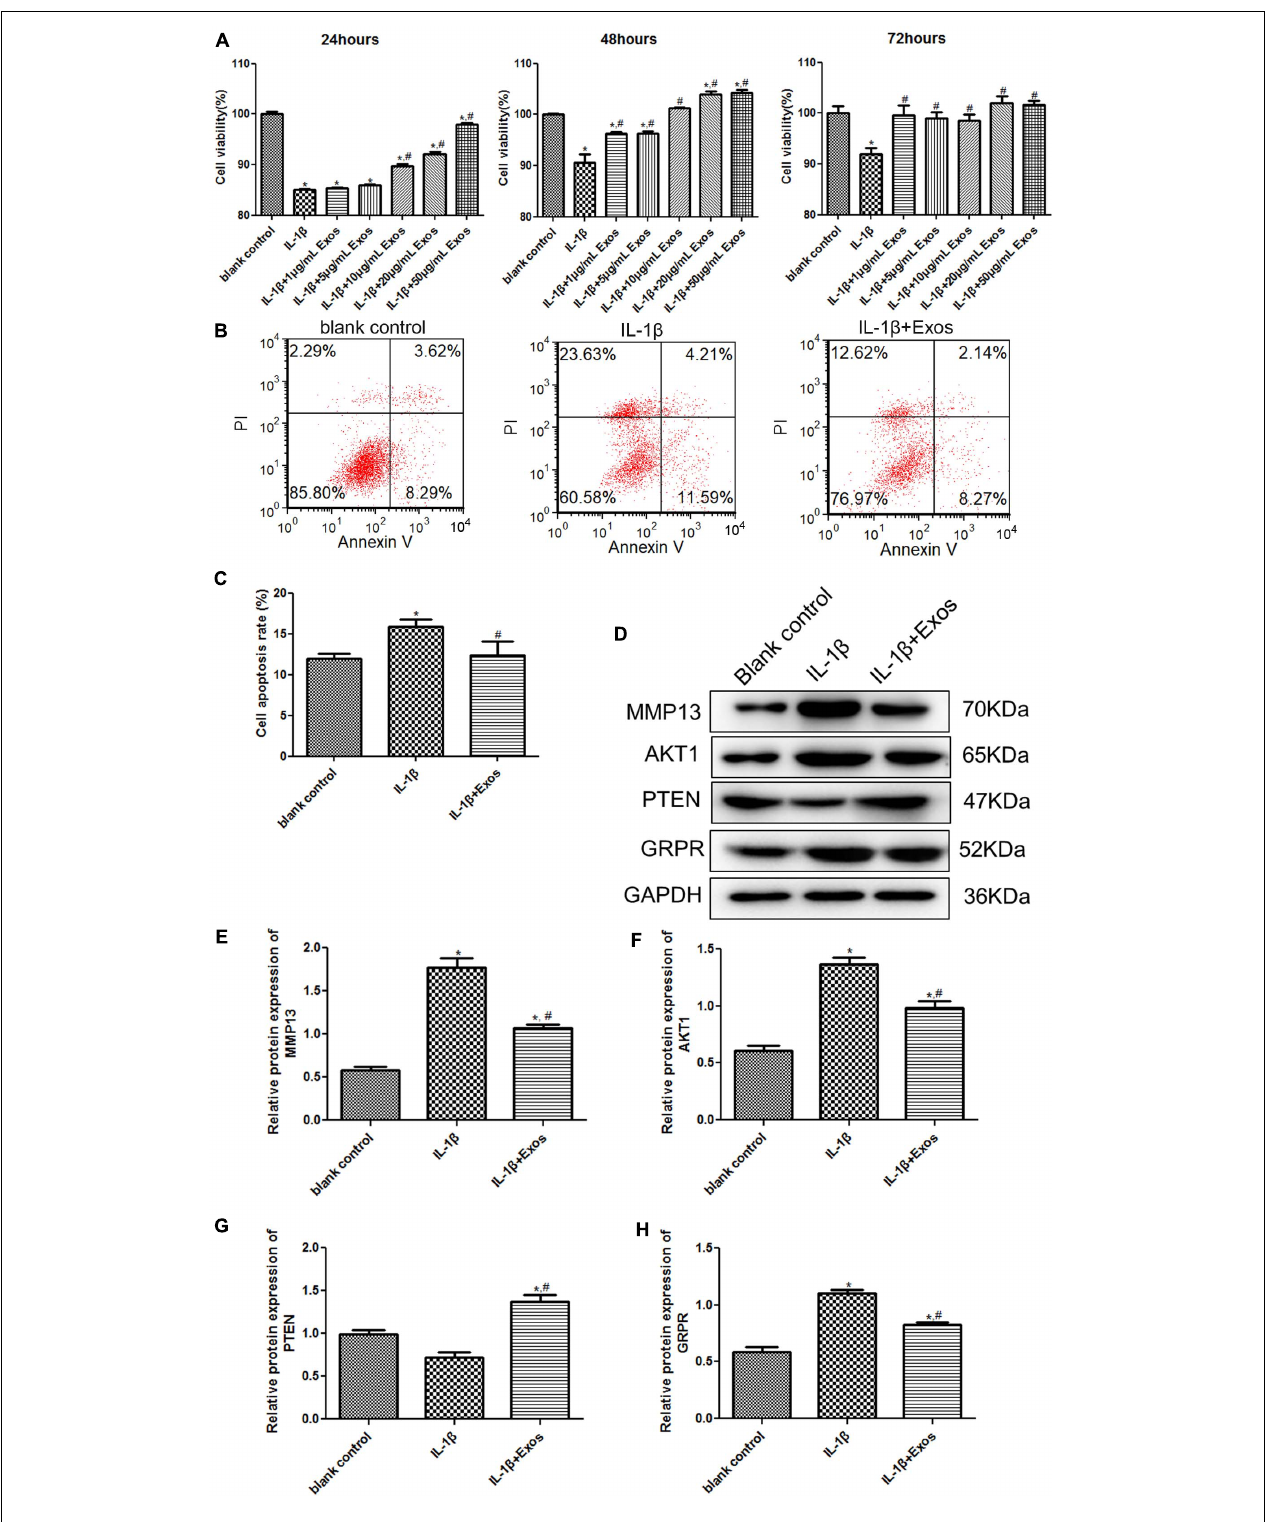
FIGURE 3 | (A) Cell viability of chondrocytes treated with different concentrations of exosomes for 24, 48, and 72 h using the Cell Counting Kit-8 (CCK-8) assay. n = 3. (B) The images of cell apoptosis acquired by flow cytometry. (C) The cell apoptosis rate of chondrocytes treated with exosomes analyzed by CellQuest software. n = 3. (D) The protein bands acquired by western blot. The protein expressions of MMP13 (E) , AKT1 (F) , PTEN (G) , and GRPR (H) after chondrocytes were treated with exosomes determined by western blot. n = 3. * P < 0.05 vs. blank control group; # P < 0.05 vs. IL-1 β group.